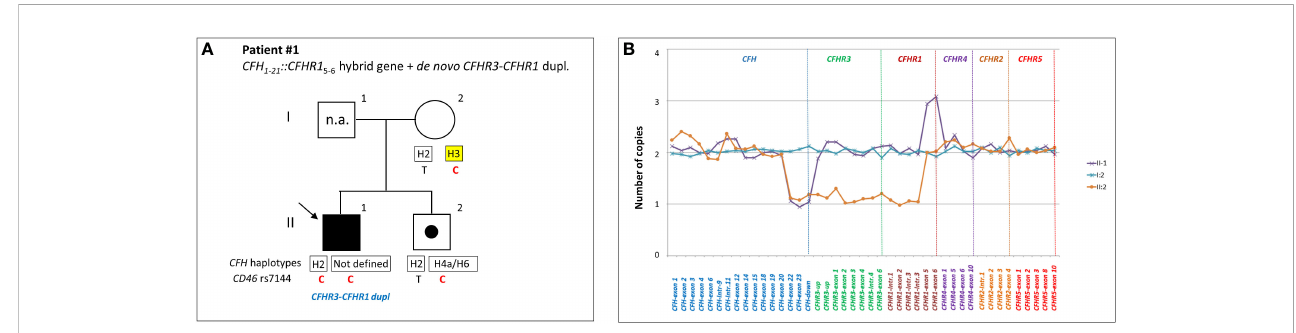
FIGURE 3 Patient #1 with a hybrid CFH 1-21 ::CFHR1 5-6 gene and a de novo CFHR3-CFHR1 duplication. (A) The proband (black arrow) is patient II:1, his father is I:1 (samples are not available, n.a.), his mother is I:2 and his brother (unaffected carrier of hybrid CFH 1-21 ::CFHR1 5-6 gene) is II:2. Genotype of CFH single nucleotide polymorphisms (snps) targeting the CFH-H3 risk (TGTGT) haplotype (c.1 – 331C>T, rs3753394; c.184G>A, p.V62I, rs800292; c.1204T>C, p.Y402H, rs1061170; c.2016A>G, p.Q672Q, rs3753396; c.2808G>T, p.E936D, rs1065489) and the CD46 snp (rs7144, c.*897 T>C) targeting the CFH-CFHR region in proband ’ s relatives CD46 GGAAC risk haplotype are reported with a yellow square and in red, respectively. (B) MLPA analysis over the shows three different patterns. Patient (II:1) exhibits one copy of CFH exons 22 and 23 and 3 copies of CFHR1 exons 5 and 6. His brother (II:2) exhibits a large heterozygous deletion from CFH exon 22 to CFHR1 intron 3, consistent with the presence of hybrid CFH 1-21 -CFHR1 5-6 gene. The mother (I:2) has a normal copy number. These results suggest that the patient and his brother inherited the hybrid CFH 1-21 ::CFHR1 5-6 gene from their father and evidenced the presence of a de novo CFHR3-CFHR1 duplication only in the